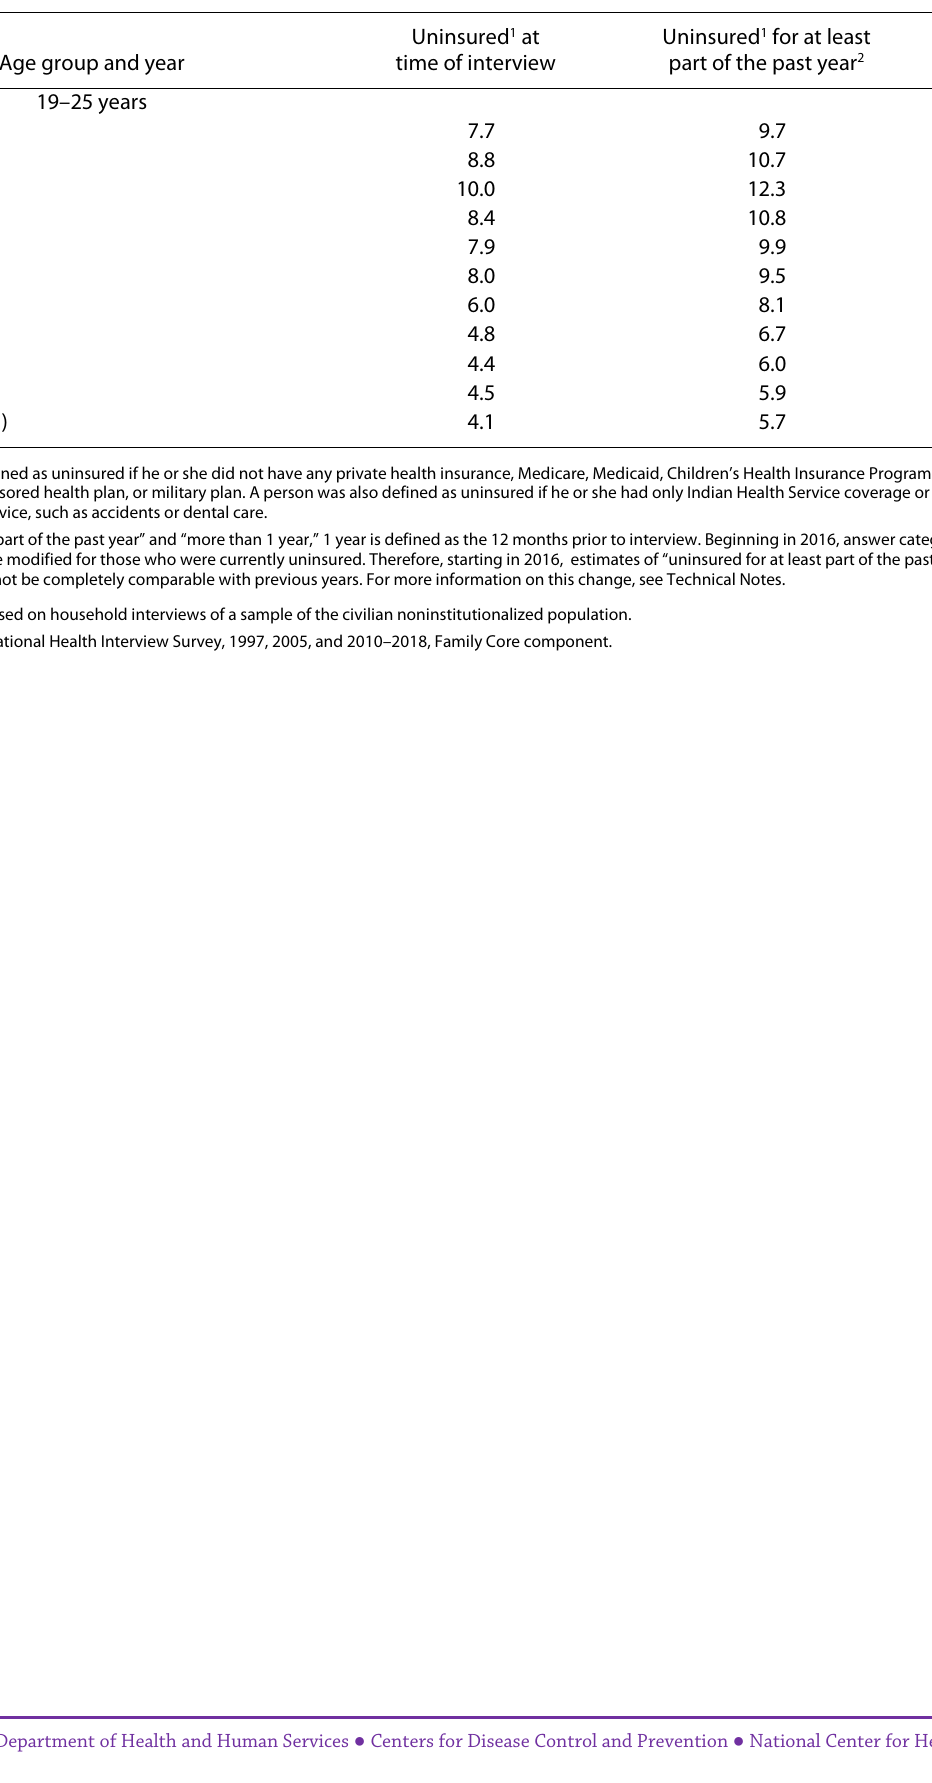
Table II. Numbers (in millions) of persons who lacked health insurance coverage at the time of interview, for at least part of the past year, and for more than 1 year, by age group and selected years: United States, 1997–June